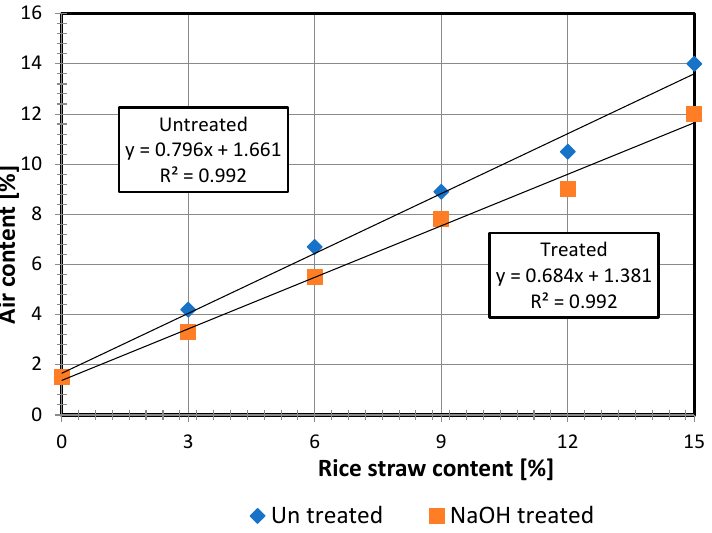
Figure 4. Air content of the treated and untreated rice straw concrete at different rice straw contents.